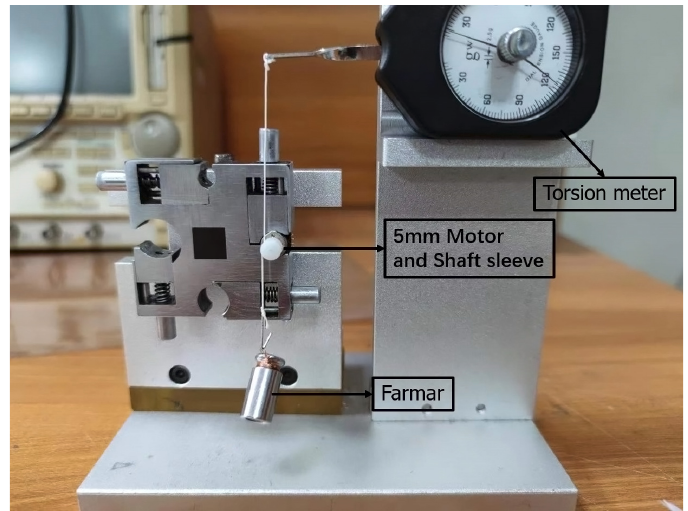
Figure 12. Micro stepper motor torque test